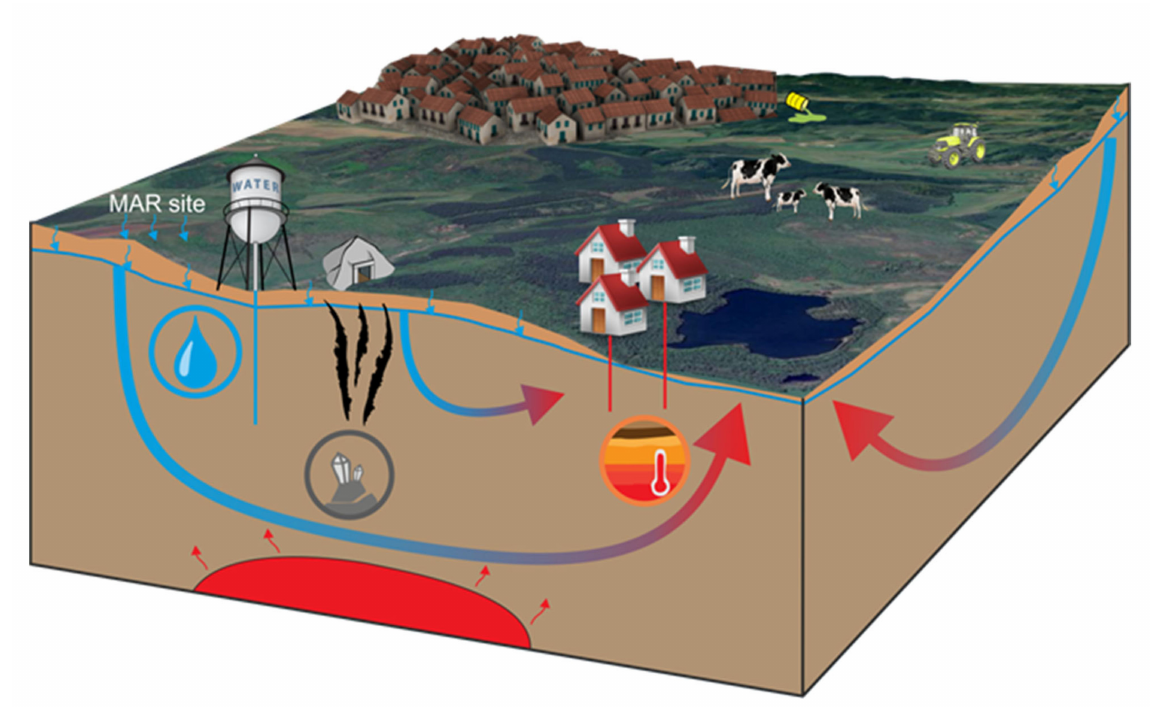
Figure 3. Dynamic System Approach for Geofluids and their Resources (DSA-GR) (water, geothermal energy, minerals). Their relationships with each other and human activities: groundwater utilization, contamination, urban areas, geothermal heating and cooling, ecology, agriculture, mining, etc. Note: upper blue line divides the unsaturated zone filled with air and fluids (directly under the ground surface), and the fully fluid-saturated zone of geofluids (highlighted by blue). The small blue arrows represent infiltration across the unsaturated zone; MAR: Managed Aquifer Recharge site; the red color and red arrows in the underside of the figure represent magmatic source of heat and hydrothermal fluids; the continuous blue–orange–red lines represent the oversimplified geofluid